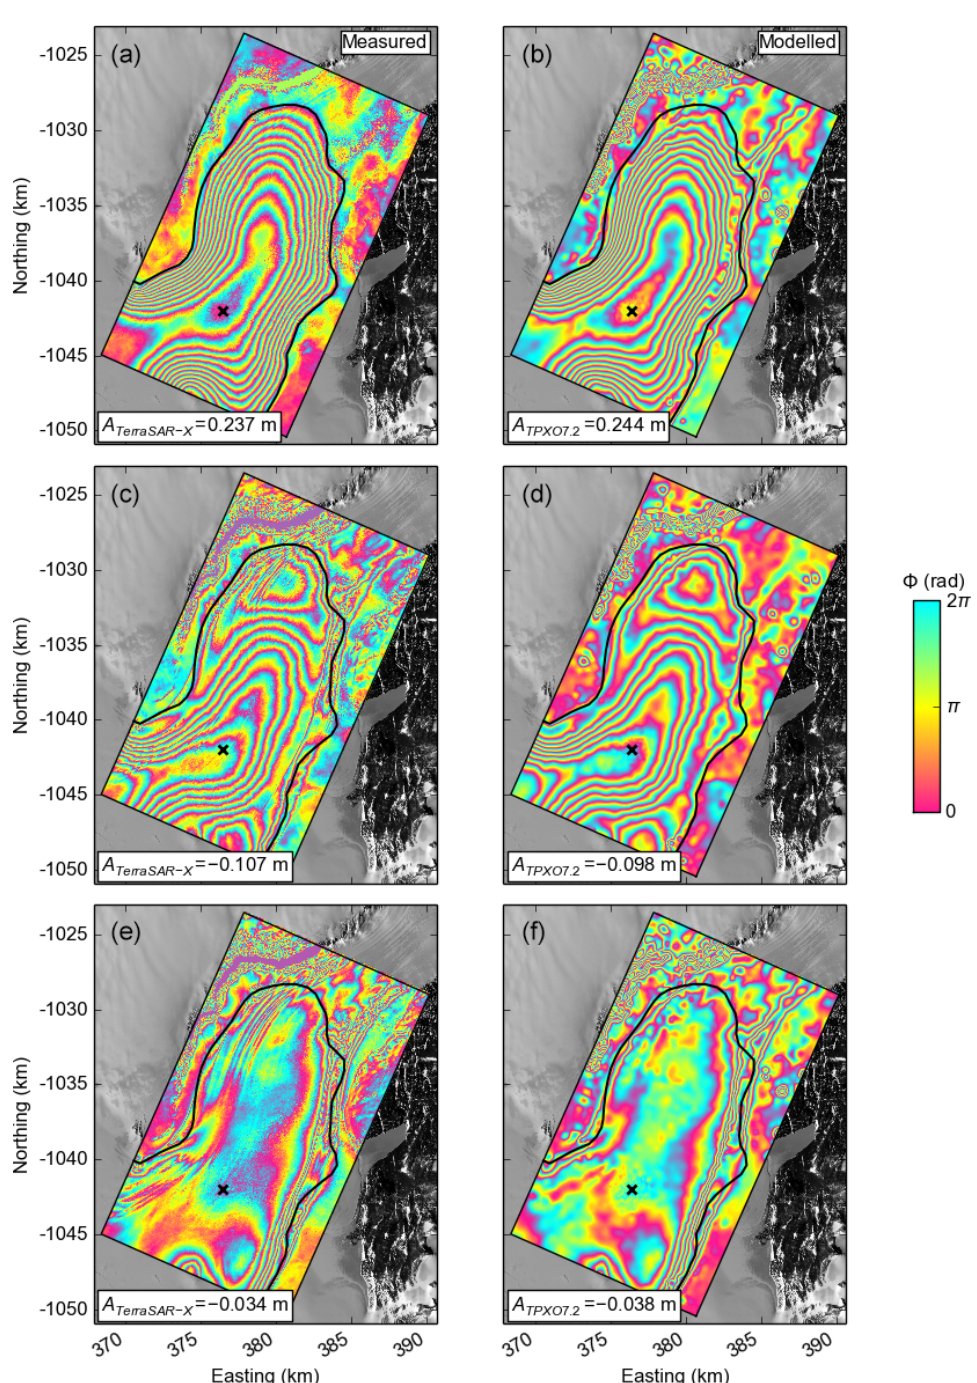
Figure 8. Selection of three measured and modelled images from 45 available DInSAR combinations. Panels (a) and (b) show conditions at a relatively large double-differential tidal amplitude (ID 37), panels (c) and (d) display a pronounced viscoelastic signal in the Darwin Glaciers grounding zone (ID 39), and panels (e) and (f) show a complex flexural pattern (ID 15).